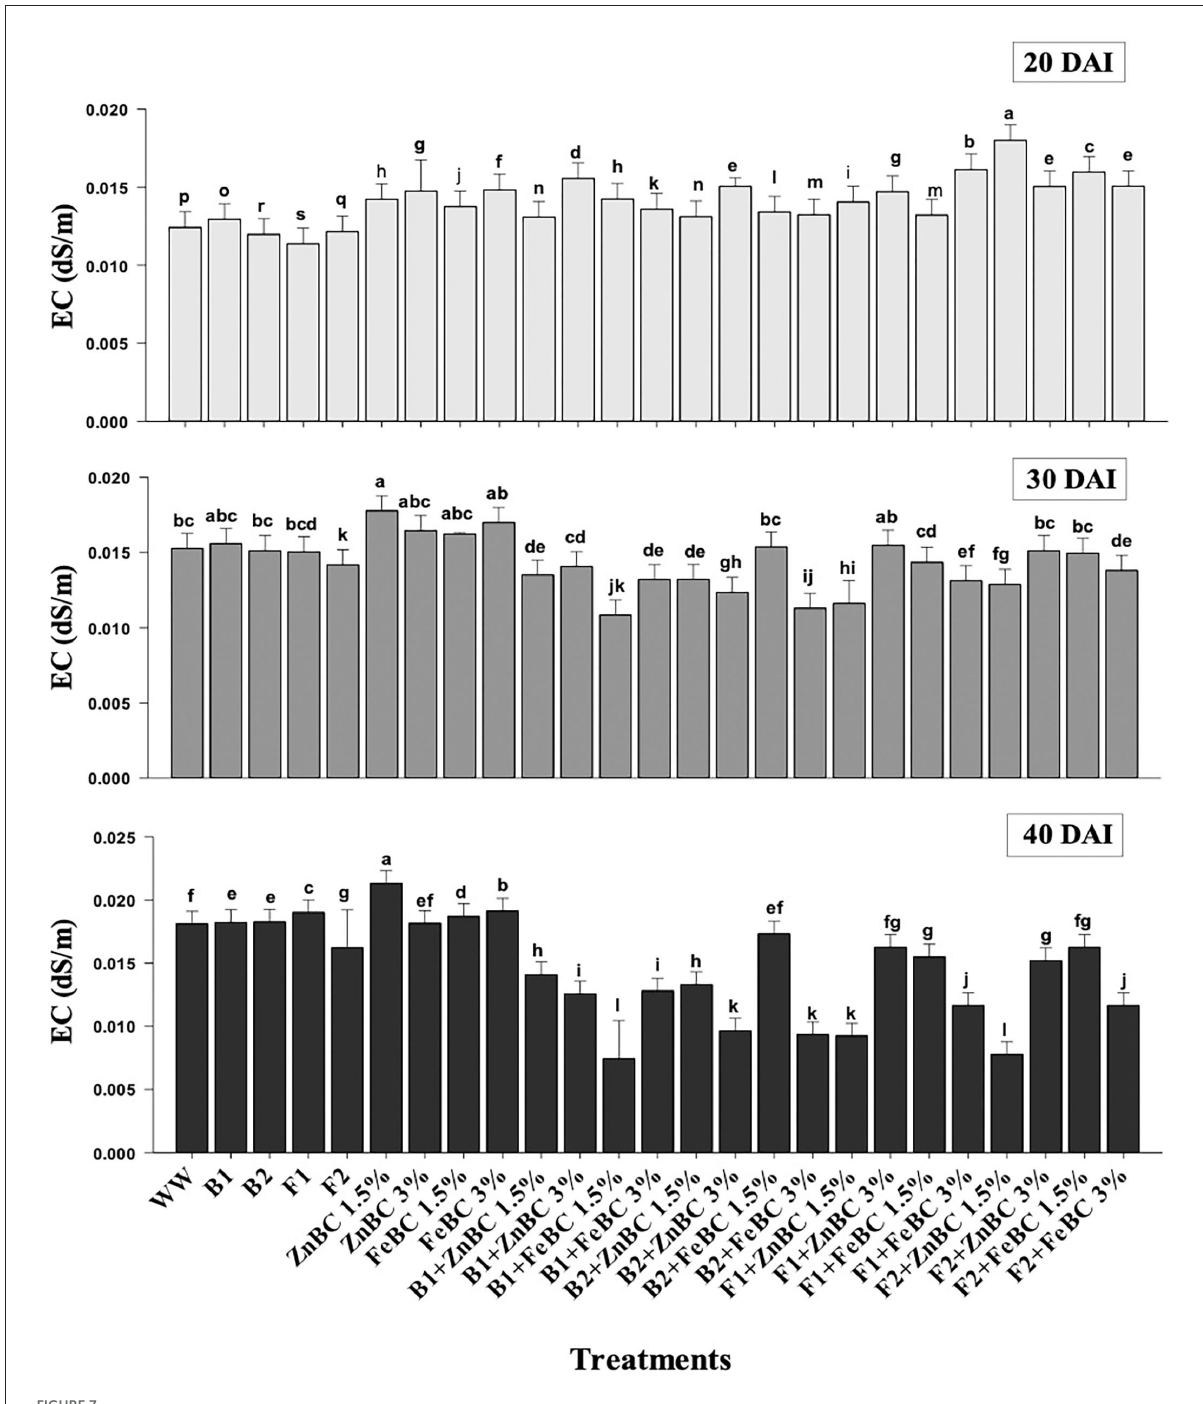
FIGURE7 Comparative analyses of EC (dS/m) for treatments (Mean ± S.D) at 20, 30, and 40 DAI periodic assessments.